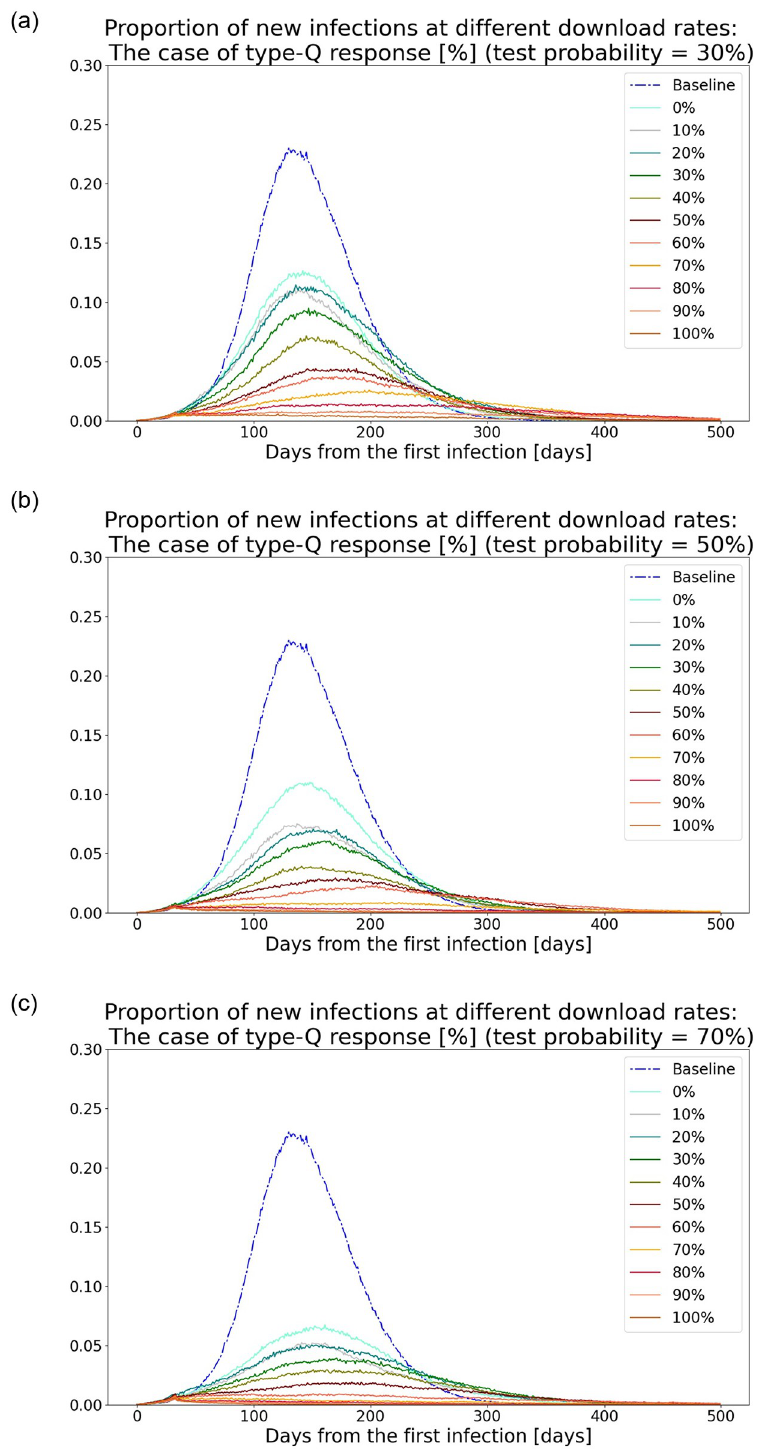
Fig 2. Proportion of new infections in the population under conditions of daily tests on randomly selected symptomatic people: Type-Q response. (a) Scenario of 30% test probability. (b) Scenario of 50% test probability. (c) Scenario of 70% test